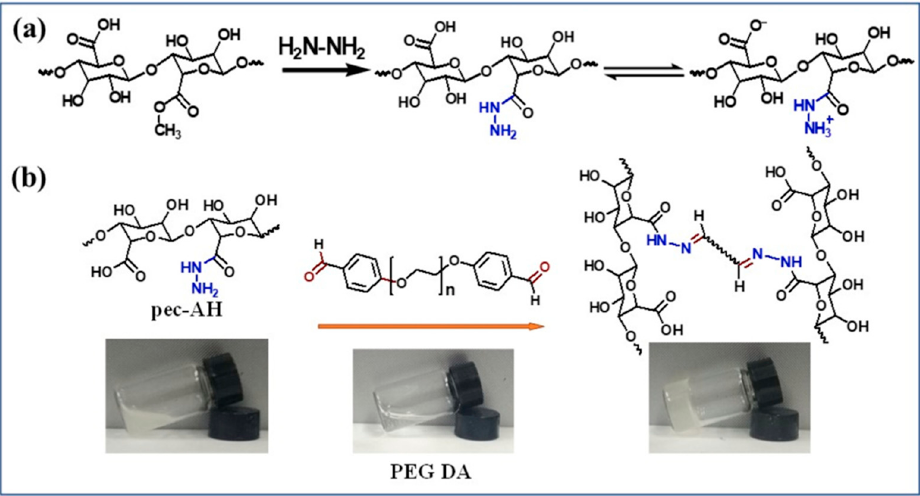
Figure 9. ( a ) Scheme for the synthesis of Pec-AH and ( b ) formation of the Pec-AH and PEG-DA hydrogel. Reproduced with permission